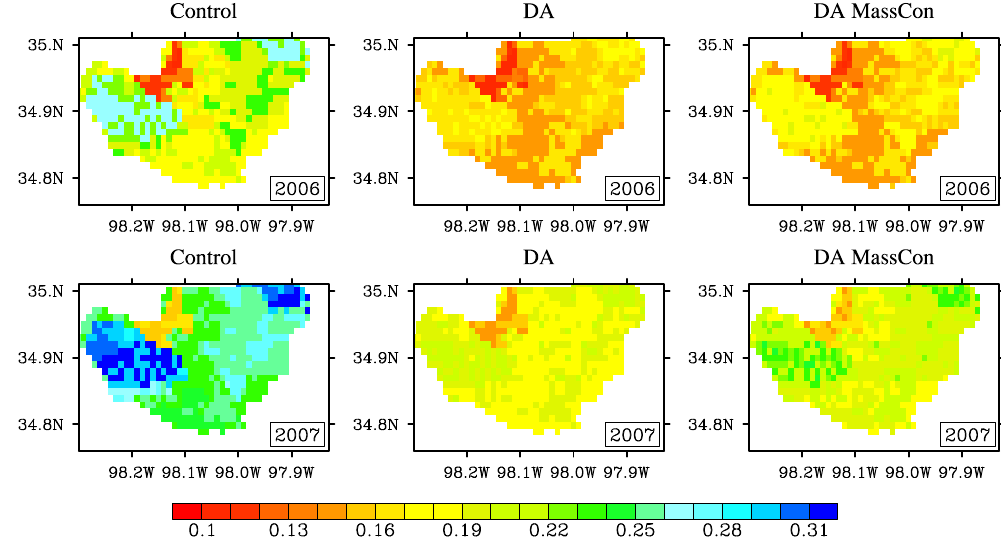
Fig. 5. Mean annual surface soil moisture (cm 3 cm − 3 ) from Control, DA and DA MassCon in 2006 and 2007.